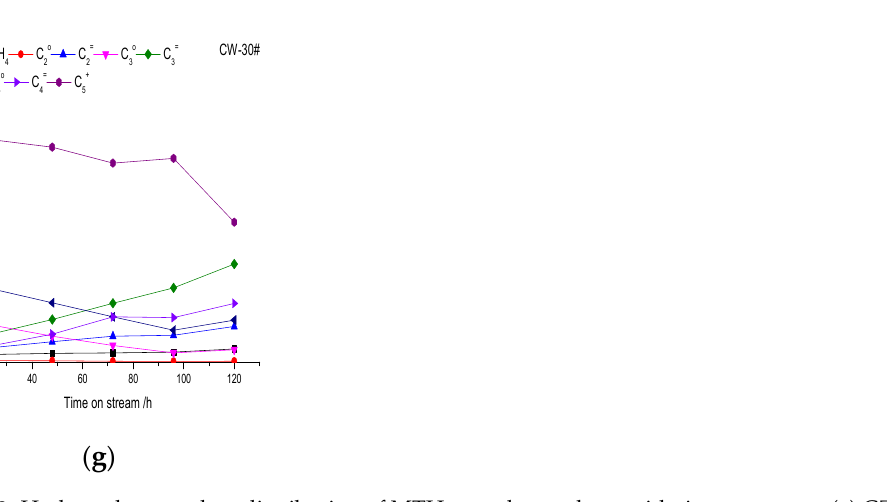
Figure 13. Hydrocarbon product distribution of MTH over the catalysts with time on stream ( a ) CZ; ( b ) CN-20; ( c ) CN-30; ( d ) CN-40; ( e ) CN-50; ( f ) CP-30; and ( g ) CW-30.